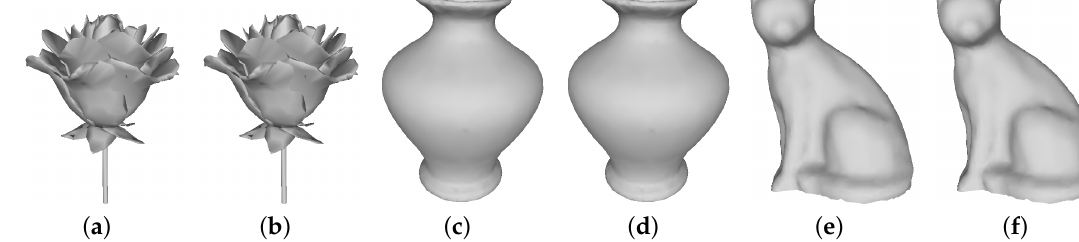
Figure 6. ( a ) Flower; ( b ) Watermarked Flower; ( c ) Vase; ( d ) Watermarked Vase; ( e ) Cup; ( f ) Watermarked